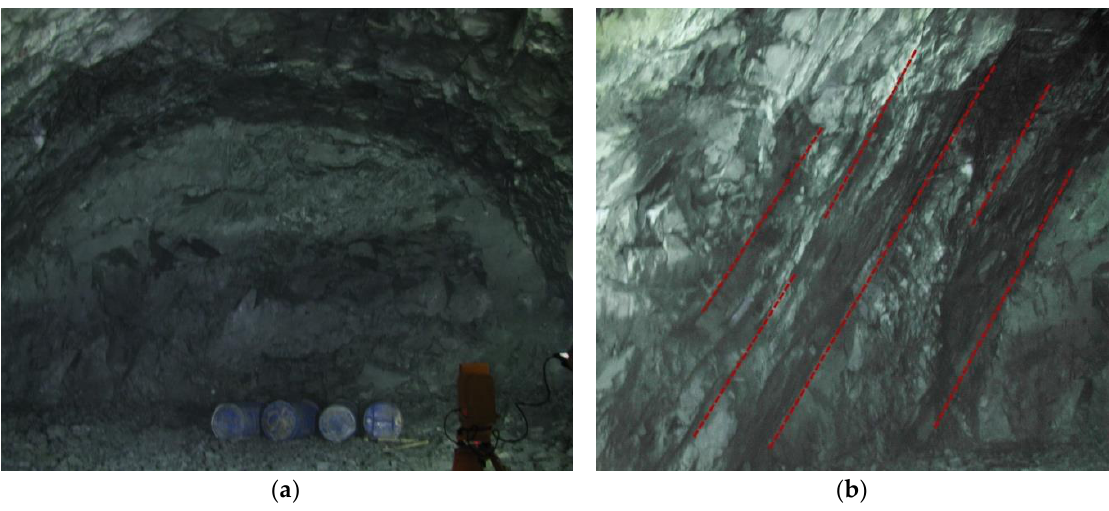
Figure 9. Numerical model with joints of bedded tunnel.